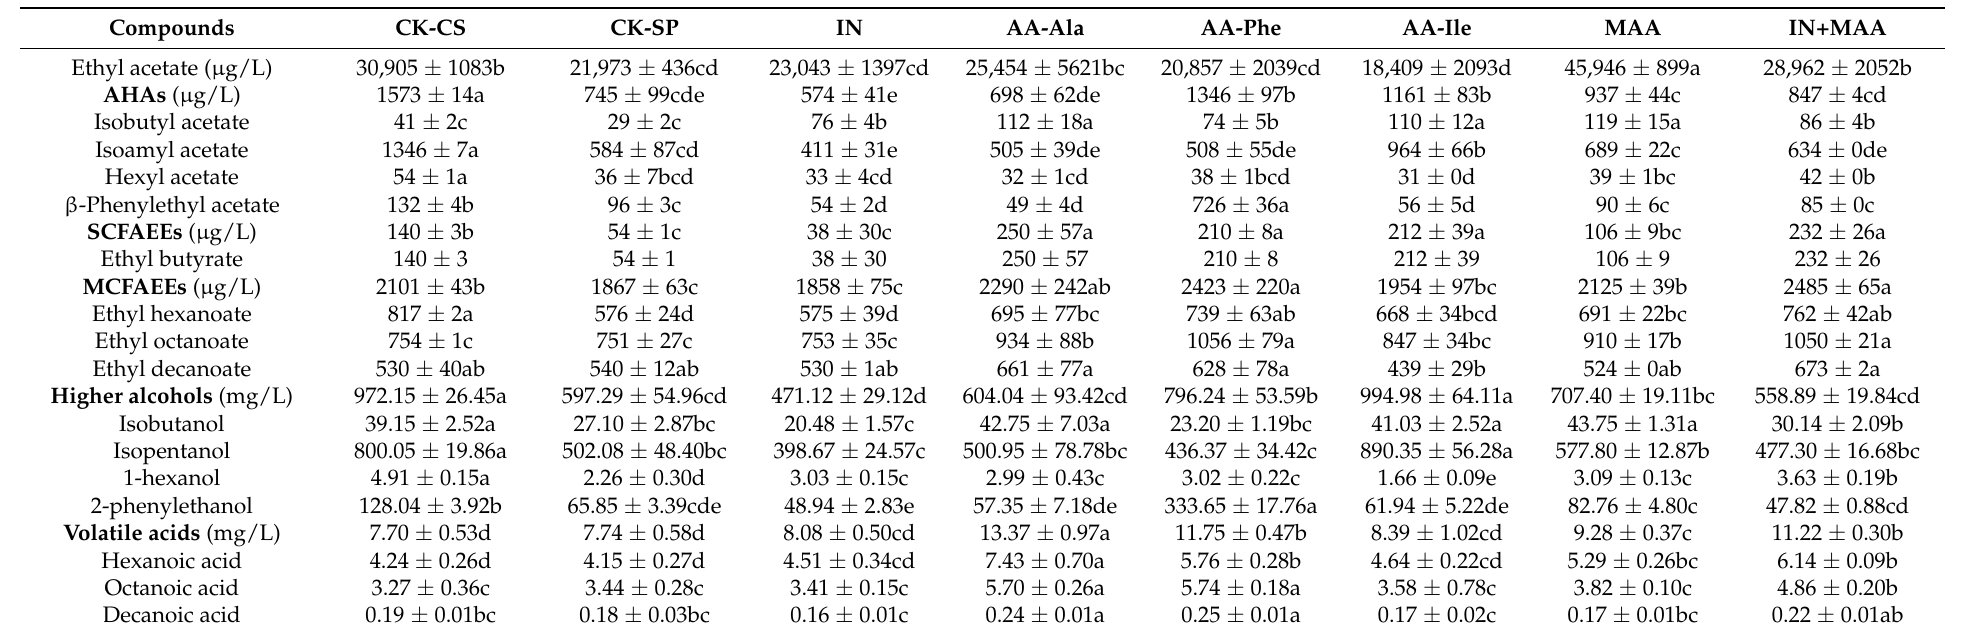
Table 3. Concentration of fruity esters and their precursors in spine grape wines obtained from different nitrogen nutrient treatments and controls. Data are mean ± standard deviation. Values displaying different letters within each row are significantly different according to the Duncan test at 95% confidence level. AHA, acetate of higher alcohol; SCFAEE, short-chain fatty acid ethyl ester; MCFAEE, medium-chain fatty acid ethyl ester; CK-CS, Cabernet Sauvignon control; CK-SP, spine grape control; IN, DAP supplement; AA-Ala, single alanine supplement; AA-Phe, single phenylalanine supplement; AA-Ile, single isoleucine supplement; MAA, mixed nitrogen supplement with alanine, phenylalanine, and isoleucine; IN+MAA, mixed nitrogen supplement with DAP, alanine, phenylalanine, and